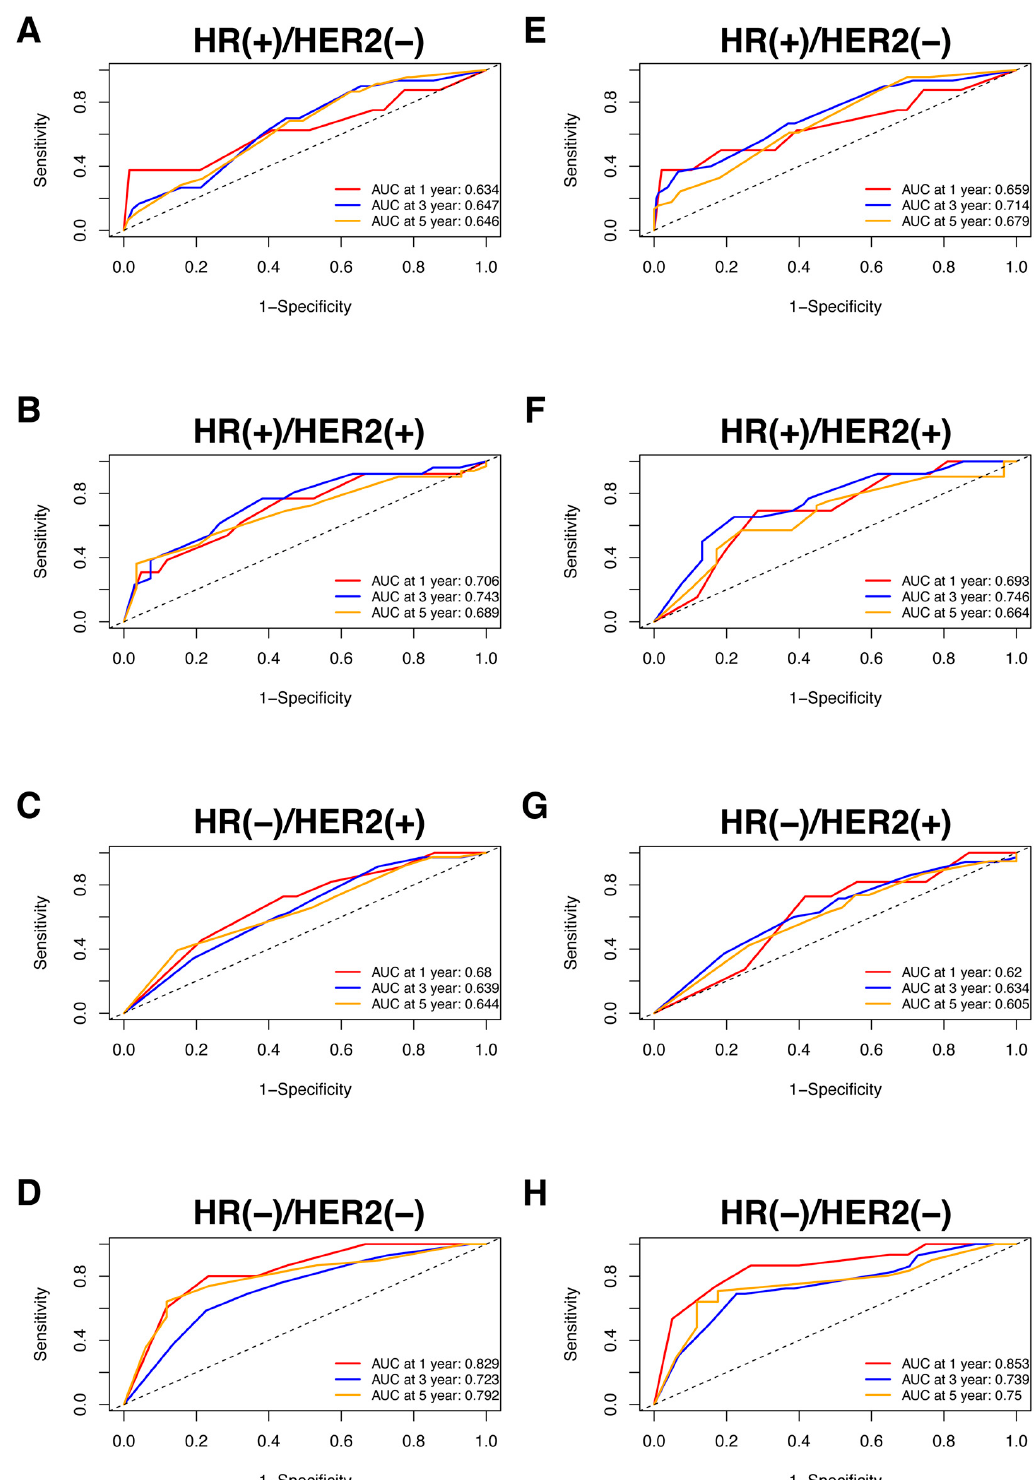
Figure 6. The ROC curve for the prediction performance of the pre-NAC nomogram model in the ( A ) HR(+)/HER2( − ), ( B ) HR(+)/HER2(+), ( C ) HR( − )/HER2(+), and ( D ) HR( − )/HER2( − ) sub- groups and the ROC curve for the prediction performance of the post-NAC nomogram model in the ( E ) HR(+)/HER2( − ), ( F ) HR(+)/HER2(+), ( G ) HR( − )/HER2(+), and ( H ) HR( − )/HER2( − ) subgroups. Dashed-line: reference line. Abbreviations: ROC, receiver operating characteristic; NAC, neoadjuvant chemotherapy; HR, hormone receptor; HER2, human epidermal growth factor receptor 2; AUC, area under the curve.